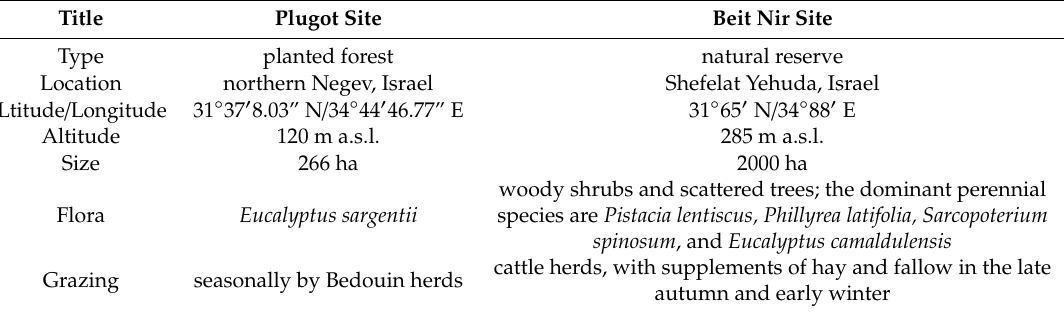
Table 1. Basic characteristics of the two research sites. Plugot Forest in the northern Negev and Beit Nir Natural Reserve area in Shefelat